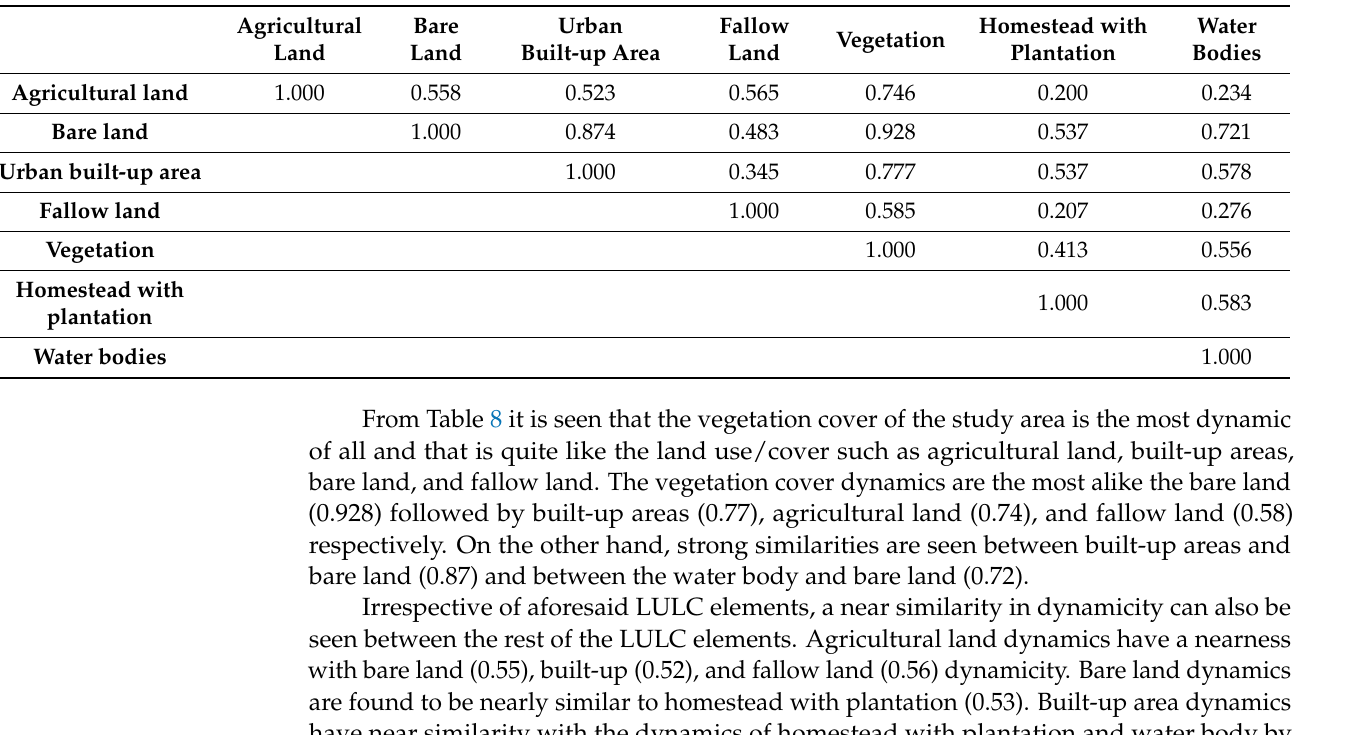
Table 8. Jaccard similarity index values per LULC